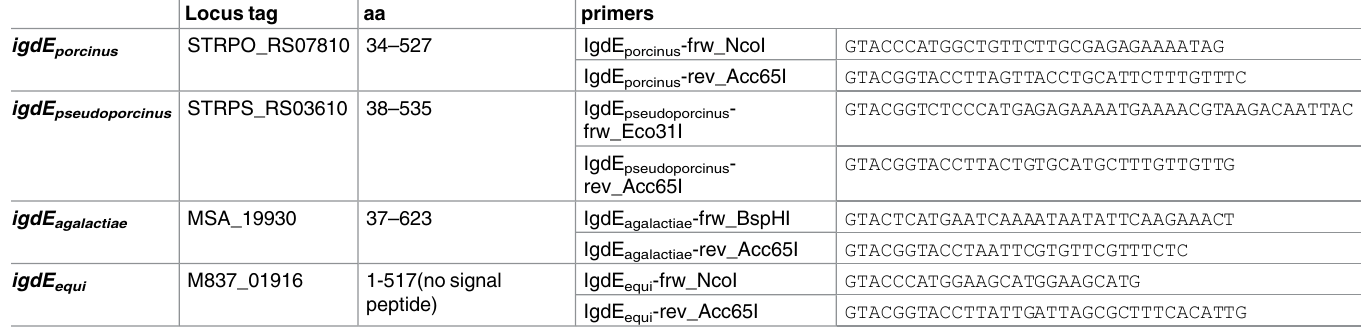
Table 1. Used primers for cloning of igdE genes. Locus tag